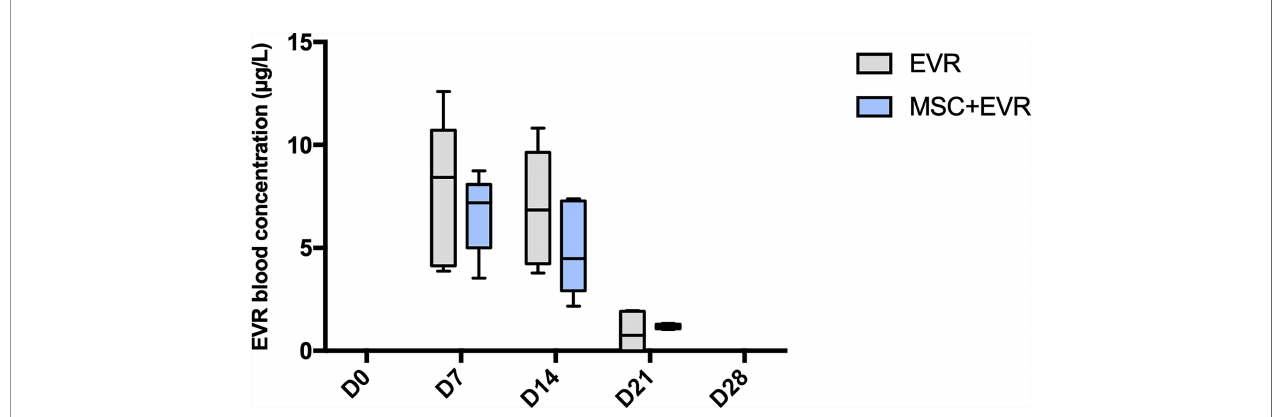
FIGURE 3 | Evolution of everolimus blood concentration. In the 2 groups (n = 6/group) receiving everolimus with osmotic pumps, the drug could be ef fi ciently delivered with a statistically increased concentration during 14 days. Plots display the median (25th and 75th percentiles) of the distributions (boxes), and whiskers extend to the minimal and maximal values. There was no statistical difference between the groups at any time point (Mann-Whitney test). (D, Day; EVR, Everolimus ; MSC, mesenchymal stromal